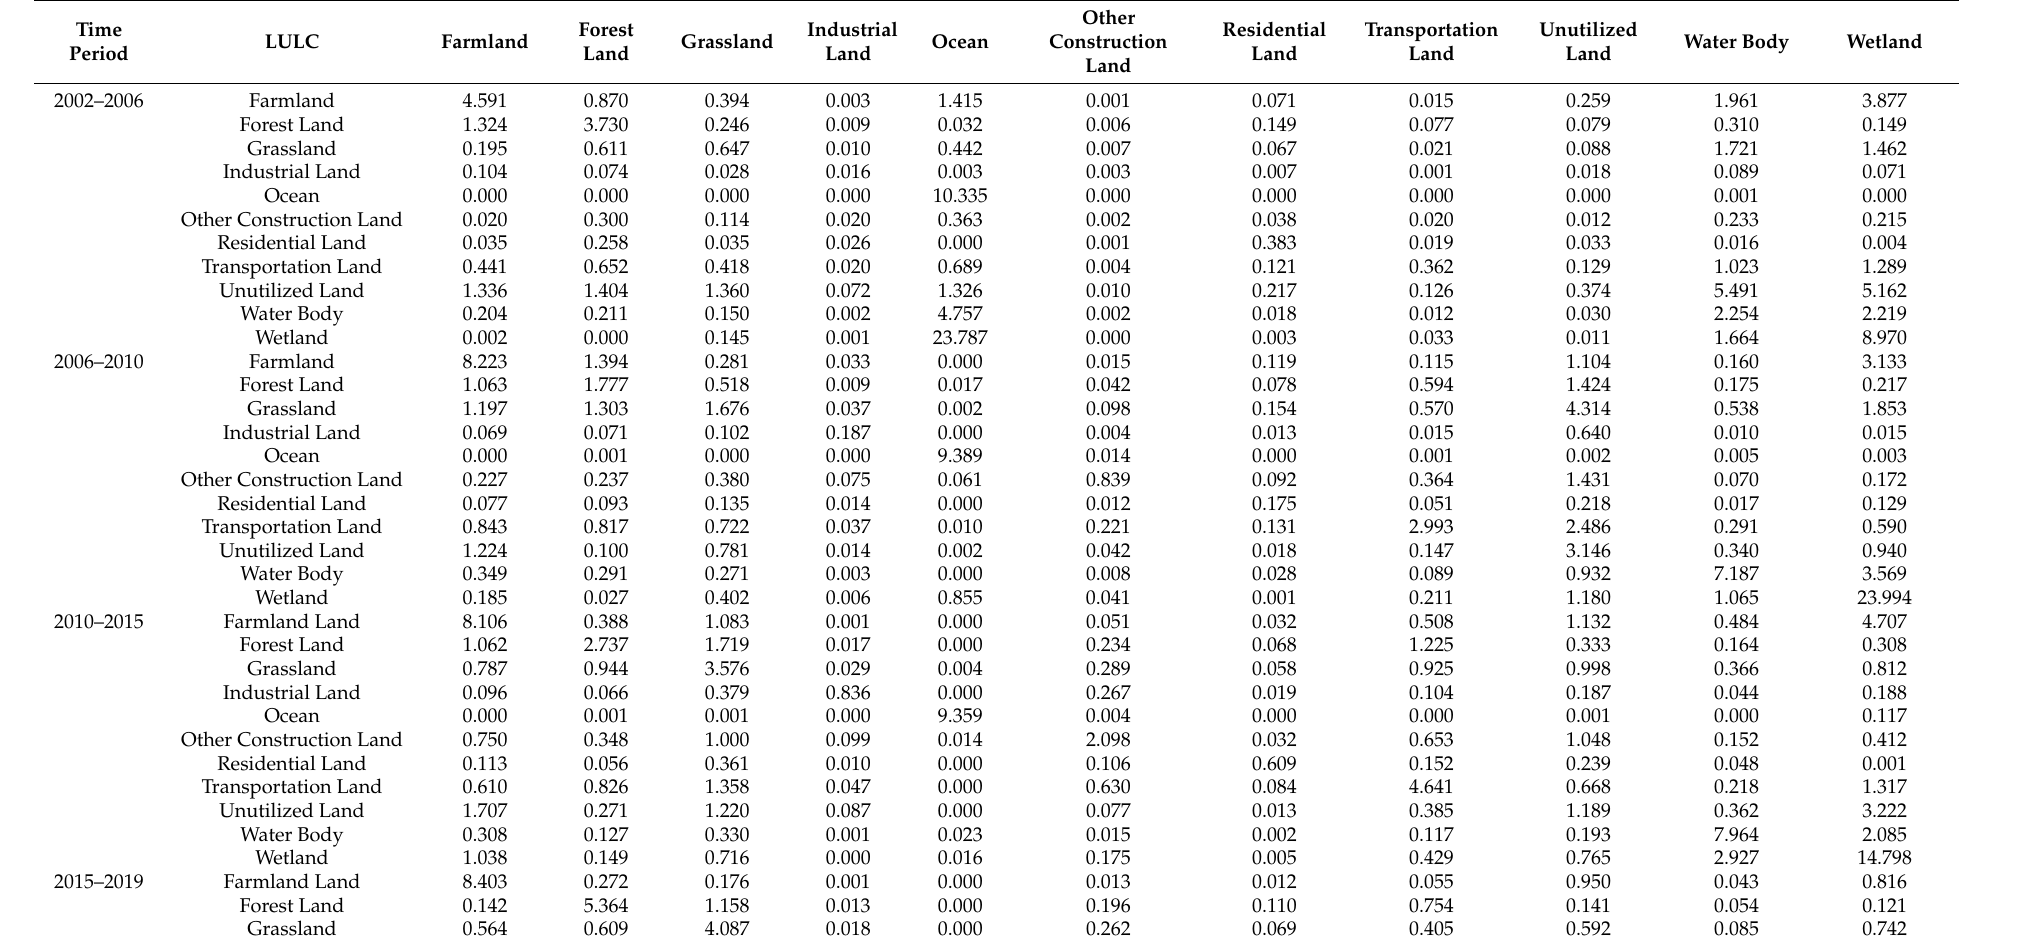
Table 1. Land use transfer matrix in the Lin-Gang core area. (km 2